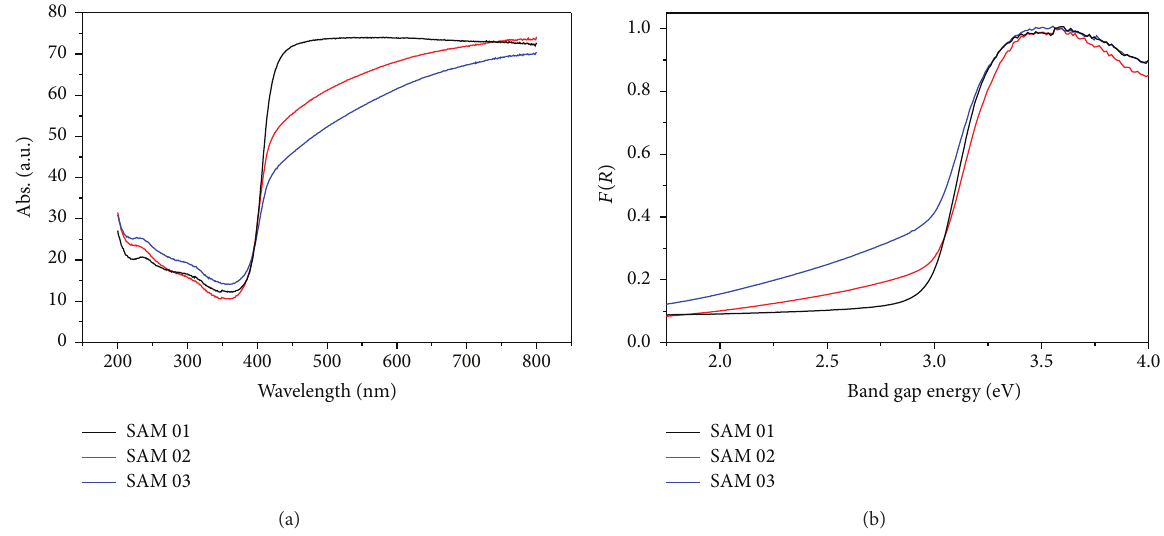
Figure 4: (a) UV-vis diffuse reflectance spectra of the samples. (b) Tauc equation function versus excitation energy of the samples for band gap determination.